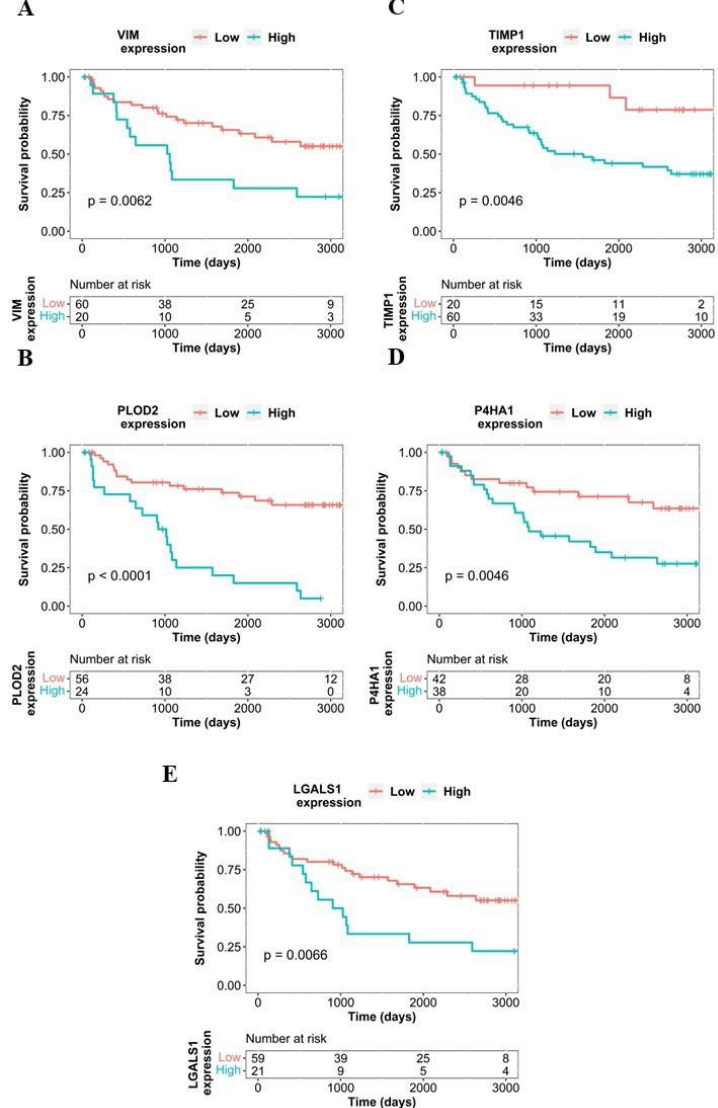
Figure 5. Kaplan–Meier plots of VIM ( A ), PLOD2 ( B ), TIMP1 ( C ), P4HA1 ( D ), LGALS1 ( E ), each protein shows a significant correlation with impaired overall survival.